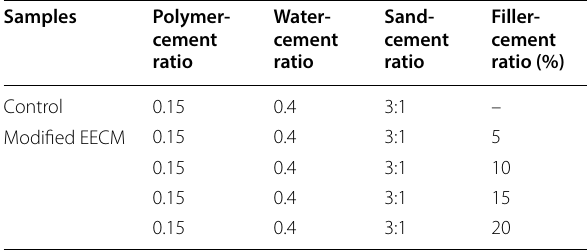
Table 3 Mix weight proportion of modified